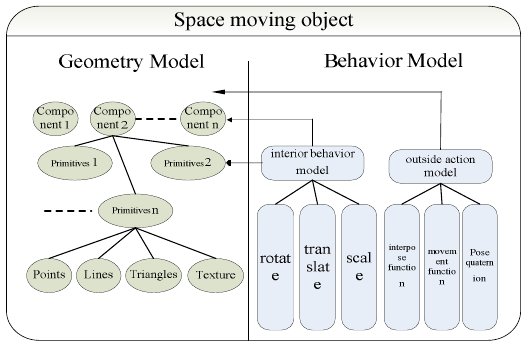
Figure 2. Space moving object Spatio-Temporal data